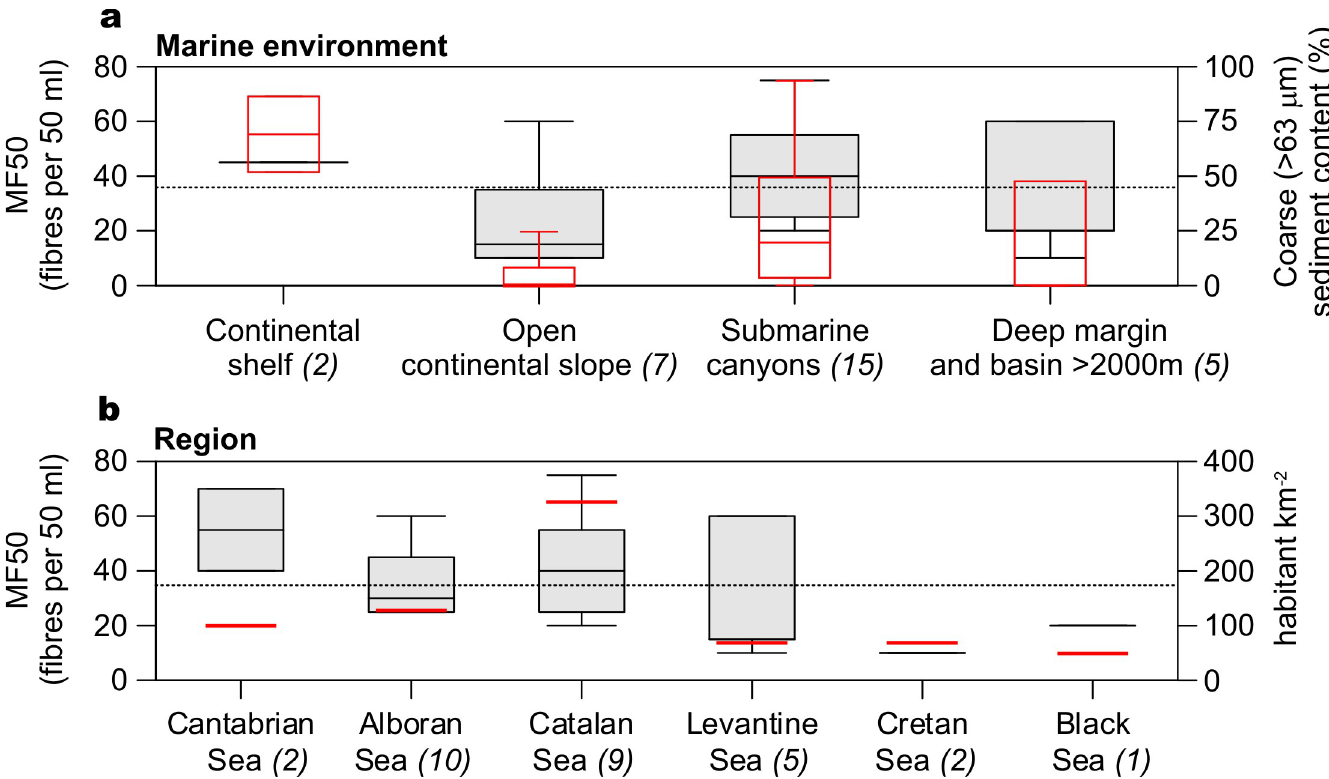
Fig 2. Boxplot showing microfibres found per 50 ml of sediment (MF50) per marine environment (a) and region (b). Volume percentage of sediments > 63 μ m and human population per square kilometer in the adjacent continental landmass [67] are also shown. The caps at the end of each box indicate the extreme values. The box is defined by the lower and upper quartiles, and the line in the center of the box is the median. The dotted line shows mean microfibre abundance. Number in brackets show the number of samples.